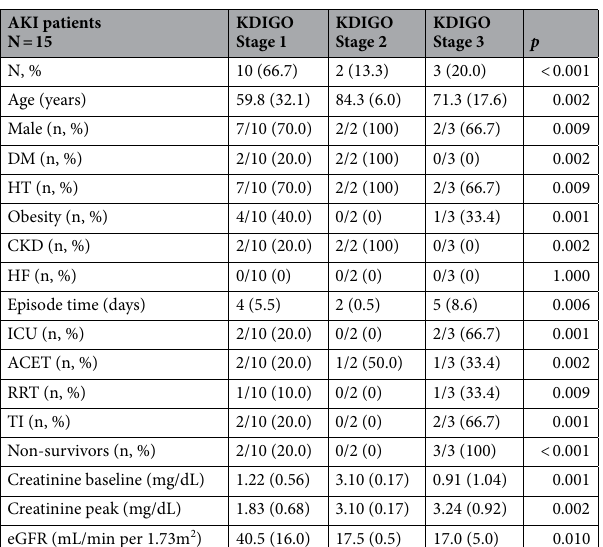
Table 4. Clinical data and biochemical results for AKI COVID-19 patients. Quantitative variables were described by mean ± standard deviation or median (IQR); AKI, Acute Kidney Injury; DM, Diabetes; HT, Hypertension; CKD, Chronic kidney disease; HF, Heart failure; ICU, Intensive Care Unit; RRT, Renal replacement therapy; TI, Tracheal intubation; ACET, Angiotensin convertase enzyme inhibitors therapy; eGFR, Estimated glomerular filtration rate; KDIGO, Kidney Disease Improving Global Outcomes.